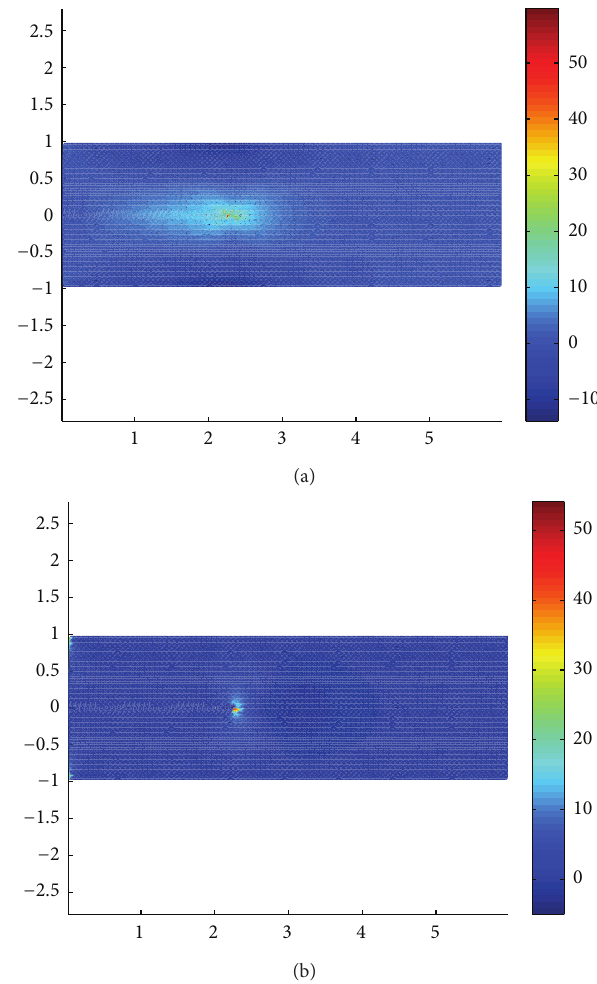
Figure 27: Stress (a) 𝜎 𝑥𝑥 and (b) 𝜎 𝑦𝑦 contours in the sheet (structured mesh) after the crack